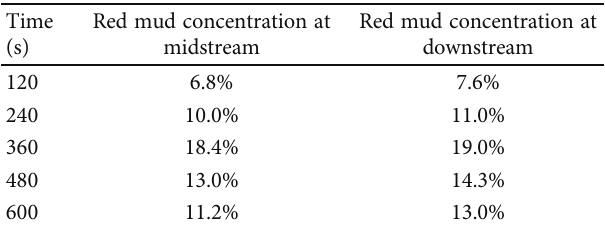
Figure 5: The mass of overtopping fl ow samples. Table 2: Red mud concentrations of the fl ow in the midstream and downstream.